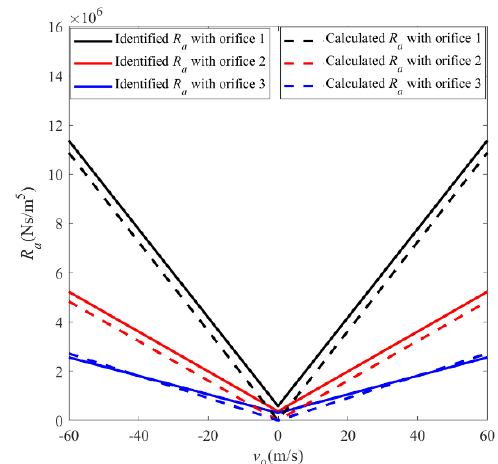
Figure 6. Comparison between the identified and calculated values of the nonlinear acoustic damping R a ( v 0 ) .